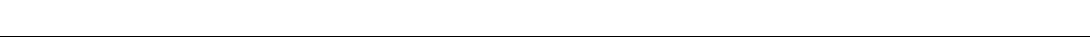
Fig. 3 Genome-wide mapping of SP5 binding sites. a Representative example of SP1- and SP5-chromatin binding. A segment of chromosome 4 illustrates the highly selective nature of SP5 binding relative to the ubiquitous transcription factor SP1. PLK4 serves a representative example of SP1 and SP5 binding in untreated and Wnt3a-treated cells. b A majority of SP5 peaks overlap with SP1 binding sites. A Venn diagram illustrates that 475 SP5 peaks overlapped with SP1 peaks. SP1 bound thousands of targets throughout the genome, whereas SP5 bound a select number of targets, including unique sites and sites shared with SP1. The complete list of SP5 peaks is provided in Supplementary Data 2. c A majority of SP5 binding sites map near transcriptional start sites. The schematic of a generic gene structure provides color-coding for the pie charts. Genomic binding locations of SP5 are categorized as transcriptional start site (TSS, de fi ned as 2 kb upstream and downstream of TSS), exon, intron, and intergenic. d Motif analysis of SP5 peaks. SP5 binding events were analyzed for overrepresented sequence motifs using MEME. (i) The most overrepresented motif for the 475 SP5 peaks with an overlapping SP1 peak closely matches the GC box. (ii) The most overrepresented motif for the 187 SP5 peaks lacking an overlapping SP1 peak diverges from the canonical GC box. (iii) The most overrepresented motif for SP1 binding summits matches the GC box. e Motif enrichment for SP1 and SP5 binding events. The fractions of peaks matching the motif in d (i) are provided for all SP1 peaks (SP1 All), SP5 peaks with overlapping SP1 peaks (SP5 w/ SP1), all SP5 peaks (SP5 All), and SP5 peaks lacking an overlapping SP1 peak (SP5 w/o SP1). f SP5 and SP1 compete for binding at select sites. The normalized average peak score is provided for all SP1 peaks (SP1 peaks All), SP1 peaks that overlap with SP5 peaks (SP1 peaks with SP5 peaks) and for all SP5 peaks (SP5 peaks) from cells that